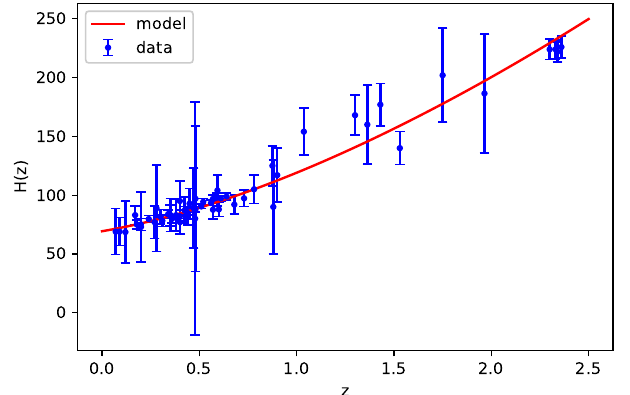
Figure 1. Error bar plot of H ( z ) versus redshift z .